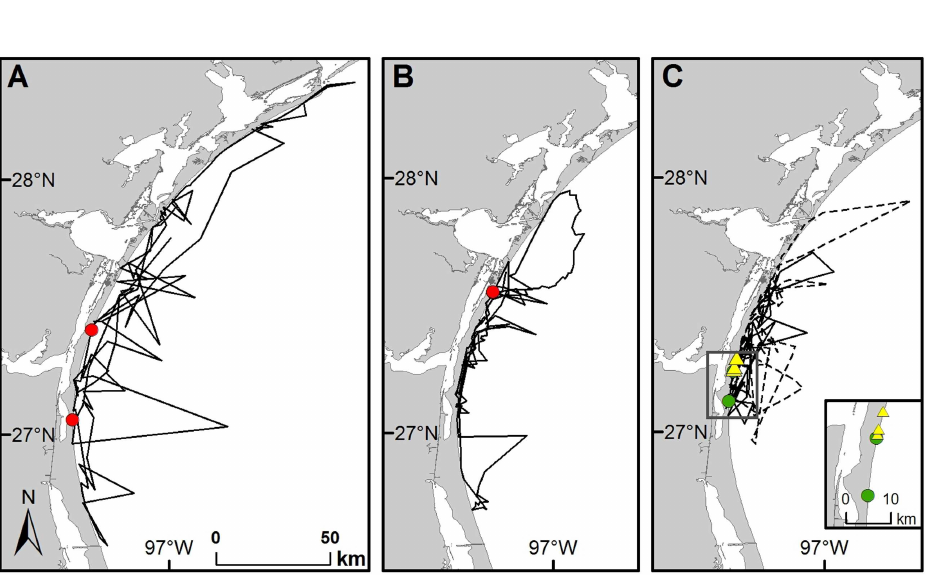
Fig 7. Examples of three different types of behavior for Kemp’s ridley turtles during the inter-nesting period. (A) No fidelity: Turtle P42, Tag number17804 (non-SSM) did not displaynest site fidelity betweentwo confirmednests (red circles, 36.8 km apart) or site fidelity to any in-water habitat duringthe 2003 nesting season. (B) Nest site fidelity only: Turtle P28, Tag number 82214(non-SSM) displayednest site fidelity betweentwo confirmednests (red circles, 0.3 km apart) but not site-fidelity to any in-water habitat duringthe 2008 nestingseason. (C) Nest site and in-water fidelity: P121 displayedboth nest-site and in-water habitat fidelity betweentwo confirmednests (green circles, 12.9 km apart) duringthe 2007 nestingseason (Tag number70703 (non-SSM), solid line) and three confirmednests (yellowtriangles, 1.1 and 4.0 km apart) duringthe 2012 nestingseason (Tag number 112758(SSM), dashed